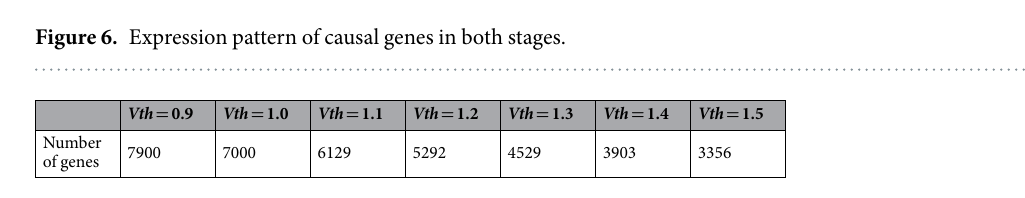
Table 4. Various gene samples drawn at different Vth